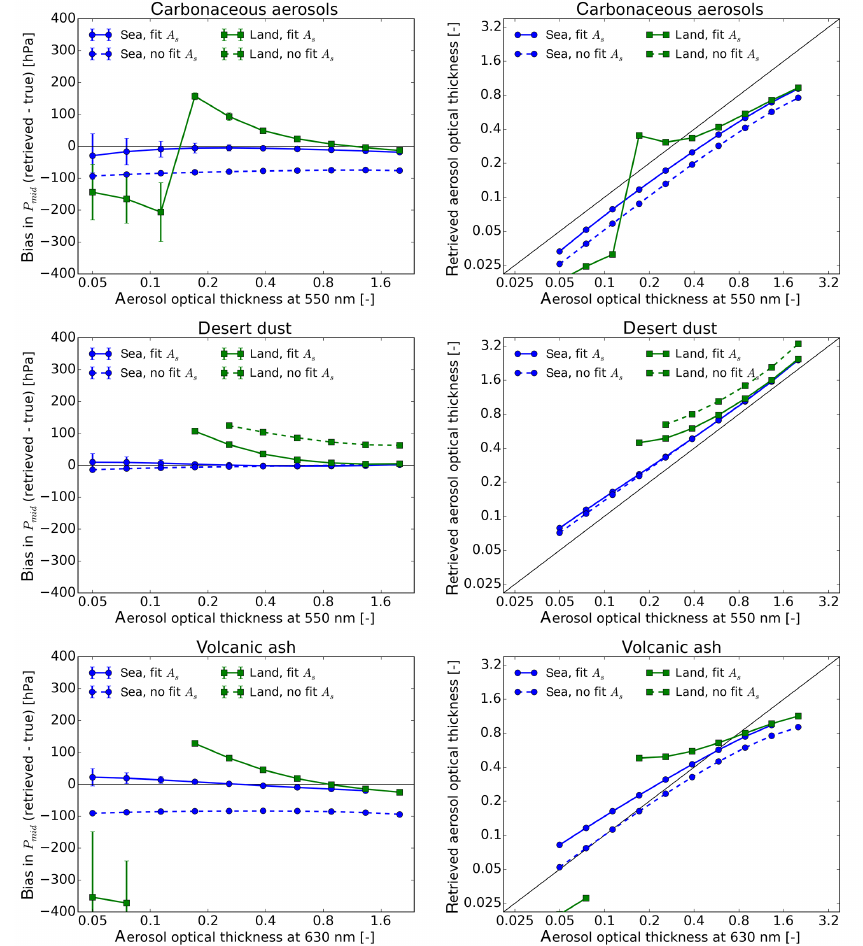
Figure 4. Results of retrieval simulations showing the bias in retrieved aerosol layer mid pressure (left column) and retrieved aerosol optical thickness (right column) as a function of the true aerosol optical thickness for three different aerosol types (rows). Measurements are simu- lated for a carbonaceous aerosol (top row), a desert dust (middle row) and a volcanic ash type (bottom row), while in the retrieval the default aerosol model is assumed (single scattering albedo of 0.95 and a Henyey–Greenstein phase function with asymmetry parameter of 0.7). The four plot lines correspond to sea (blue, circles) and land (green, squares) and to not fitting (dashed lines) and fitting (solid lines) the surface albedo. The aerosol layer is located between 700 and 600hPa. Missing data points indicate non-converging retrievals. The solar zenith angle is 50 ◦ and the viewing direction is nadir. All other settings are the same as in the simulation study of Sect. 2 (see also Figs. 1 and 2).